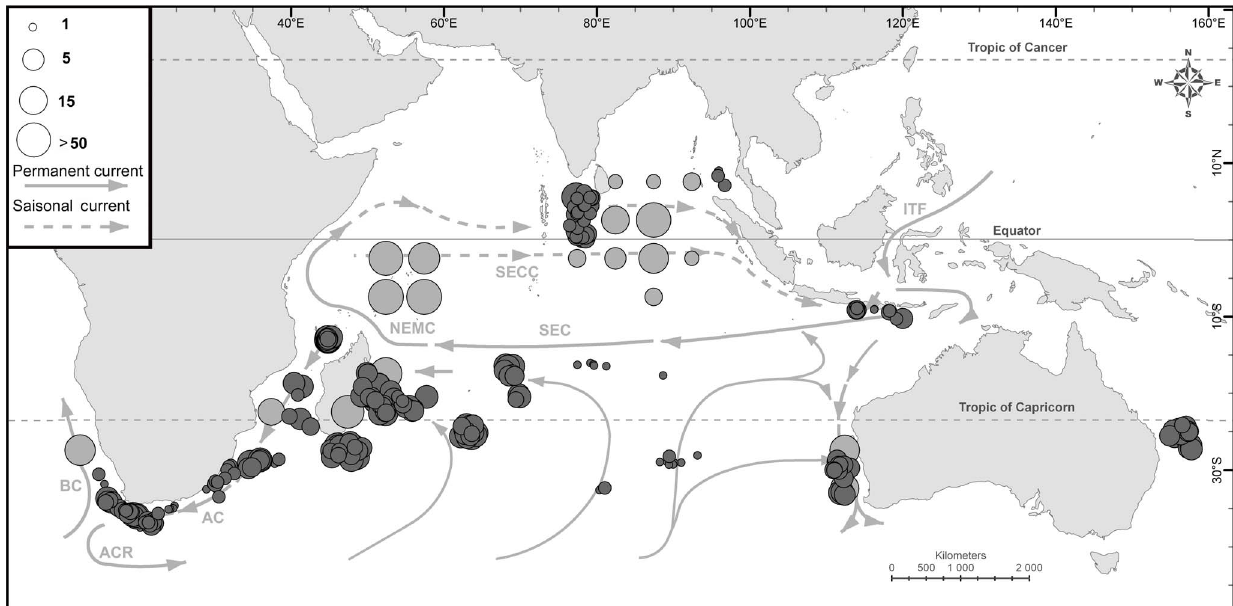
Figure 1. Geographic location of Swordfish tissue samples analysed in this study. The size of circles is proportional to number of swordfish sampled; the colour indicates the accuracy of the localisation data collected (dark grey for exact coordinates and light grey for 5 u square position). This map also shows the main Indian Ocean currents (from Schott et la. 2009); SEC: South Equatorial Current; SECC: South Equatorial Counter Current; NEMC: Northeast Madagascar Current; AC: Agulhas Current; ACR: Agulhas Current Retroflexion; BC=Benguela Current; ITF: Indonesian Trough Flow.